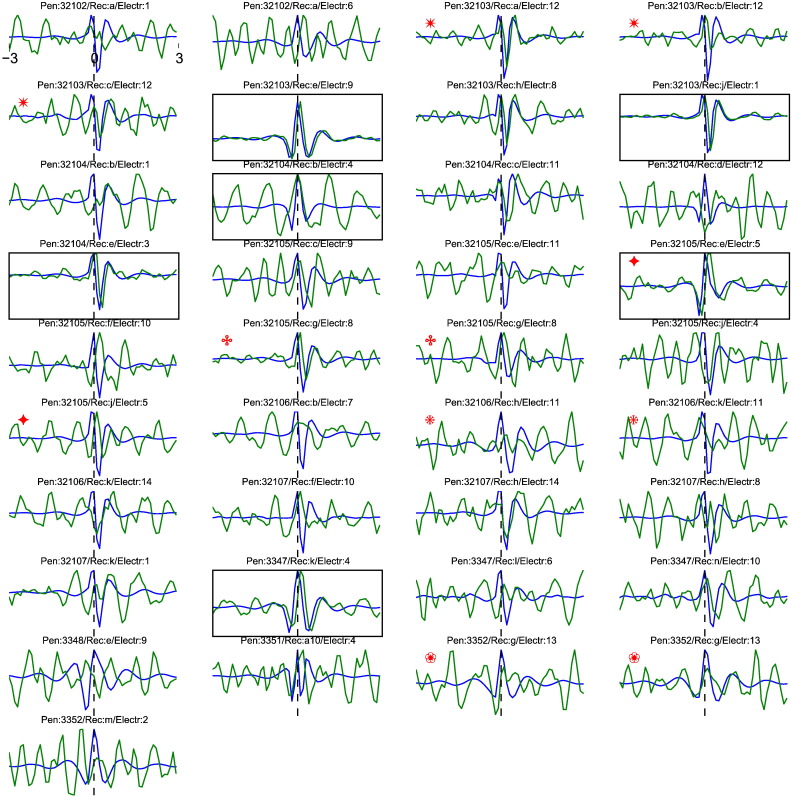
Comparison between spike waveform (blue) and single-cell EEG-STA (green) normalised to unit amplitude. Each panel shows one cell; cells for which EEG-STA peaks were significantly above noise level (cf. Fig. 2b) are highlighted with a black box. Note the striking similarity of waveforms despite a small temporal shift (0.2 ms) in some of the cells. Some EEG-STAs recorded with the same electrode and during the same penetration (grouped by red symbols in the top left corner; penetration, recording and electrode in the title of each panel) differ substantially in amplitude, which disfavours electrical cross-talk.